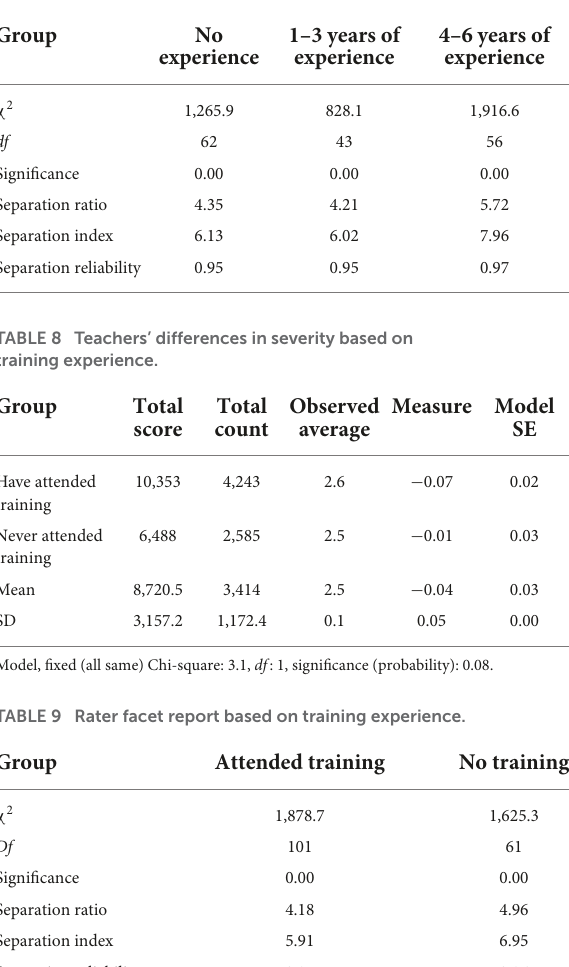
TABLE 11 Rater facet report based on teaching